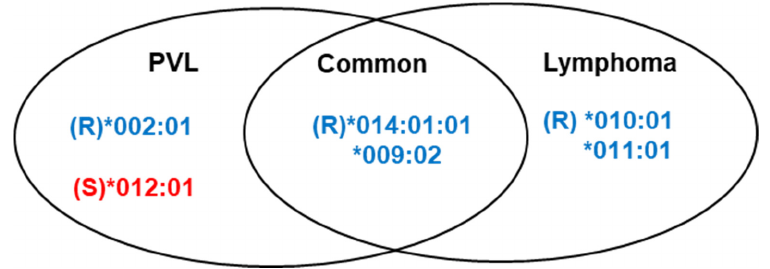
Figure 6. Summary of the differences in BoLA-DRB3 allele-associated proviral load (PVL) Figure6. Summary of the di ff erencesin BoLA-DRB3 allele-associatedproviral load(PVL) and lymphoma